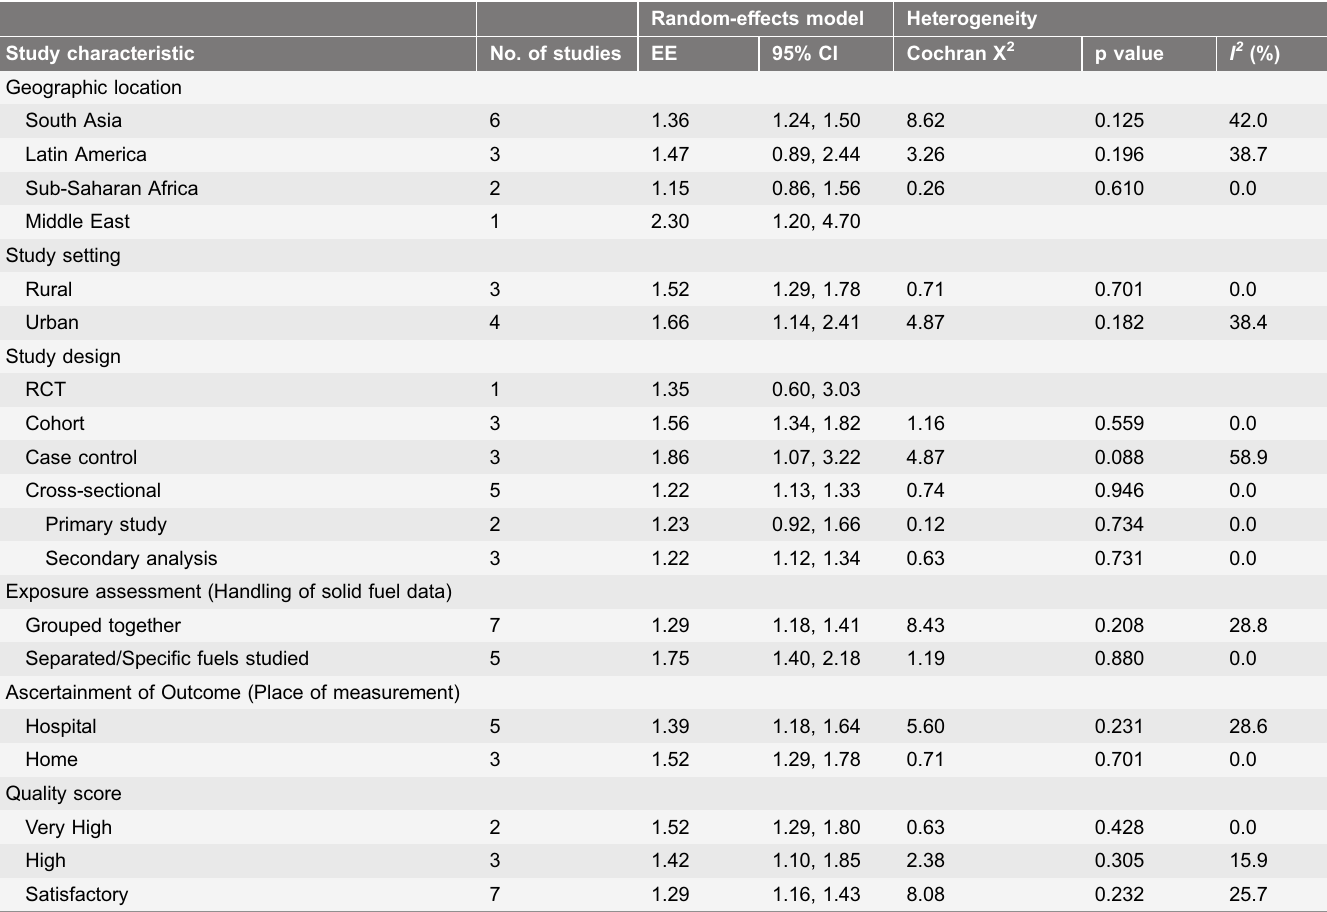
Table 6. Summary-effect estimate for the relation of solid fuel use with low birth weight stratified according to the study